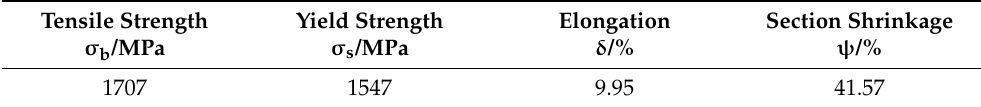
Table 2. Tensile properties of the 51CrV4 spring steel after heat treatment.